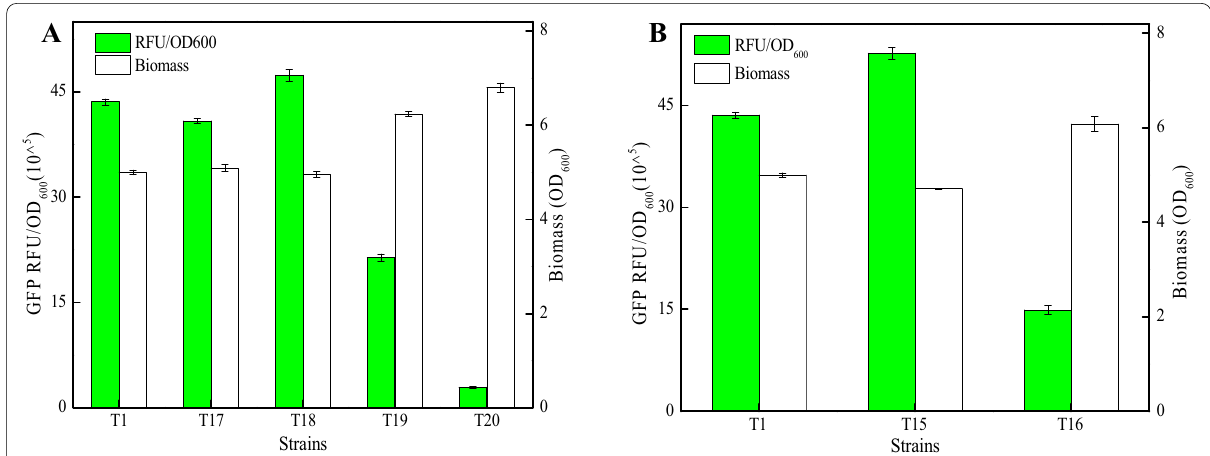
Fig. 3 Effect of stem-loop structure on intrinsic terminator T1. A Green fluorescence intensities and cell biomasses of strains with different terminators (T15–T16). B Green fluorescence intensities and cell biomasses of recombinant strains